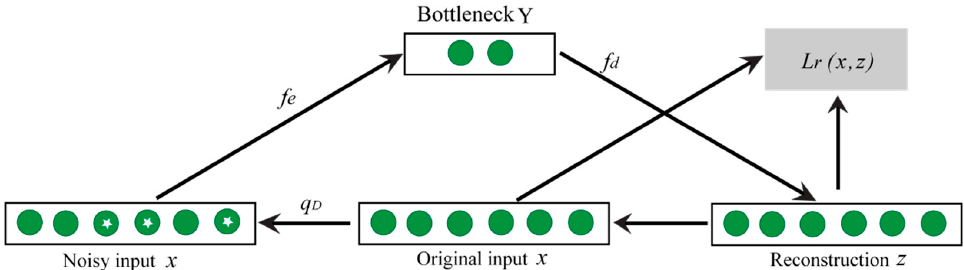
Figure 3. The illustration of the denoising auto-encoder. Where, for example, 𝑥 is randomly corrupted to 𝑥(cid:3556) , then the encoder function 𝑓 (cid:3032) maps it to 𝑌 and tries to reconstruct 𝑧 by using the decoder function 𝑓 (cid:3031) . Reconstruction error 𝐿 (cid:3045) (x,z) is measured in terms of a loss function.